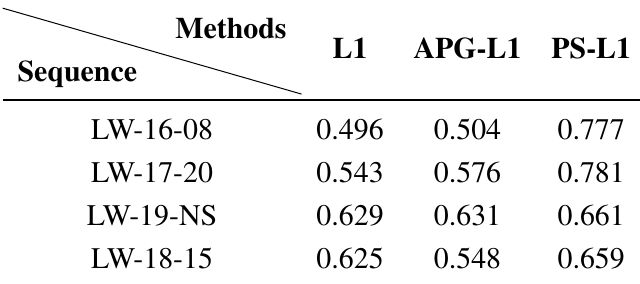
Table 2. Numerical Comparison of Average of